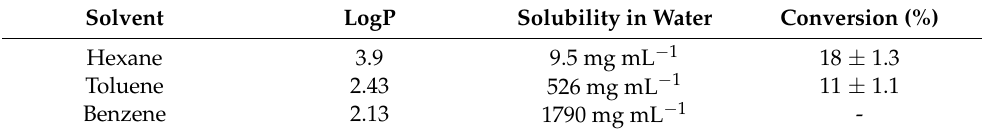
Table 1. Effects of various organic solvents on IBU-sorbitol ester production by